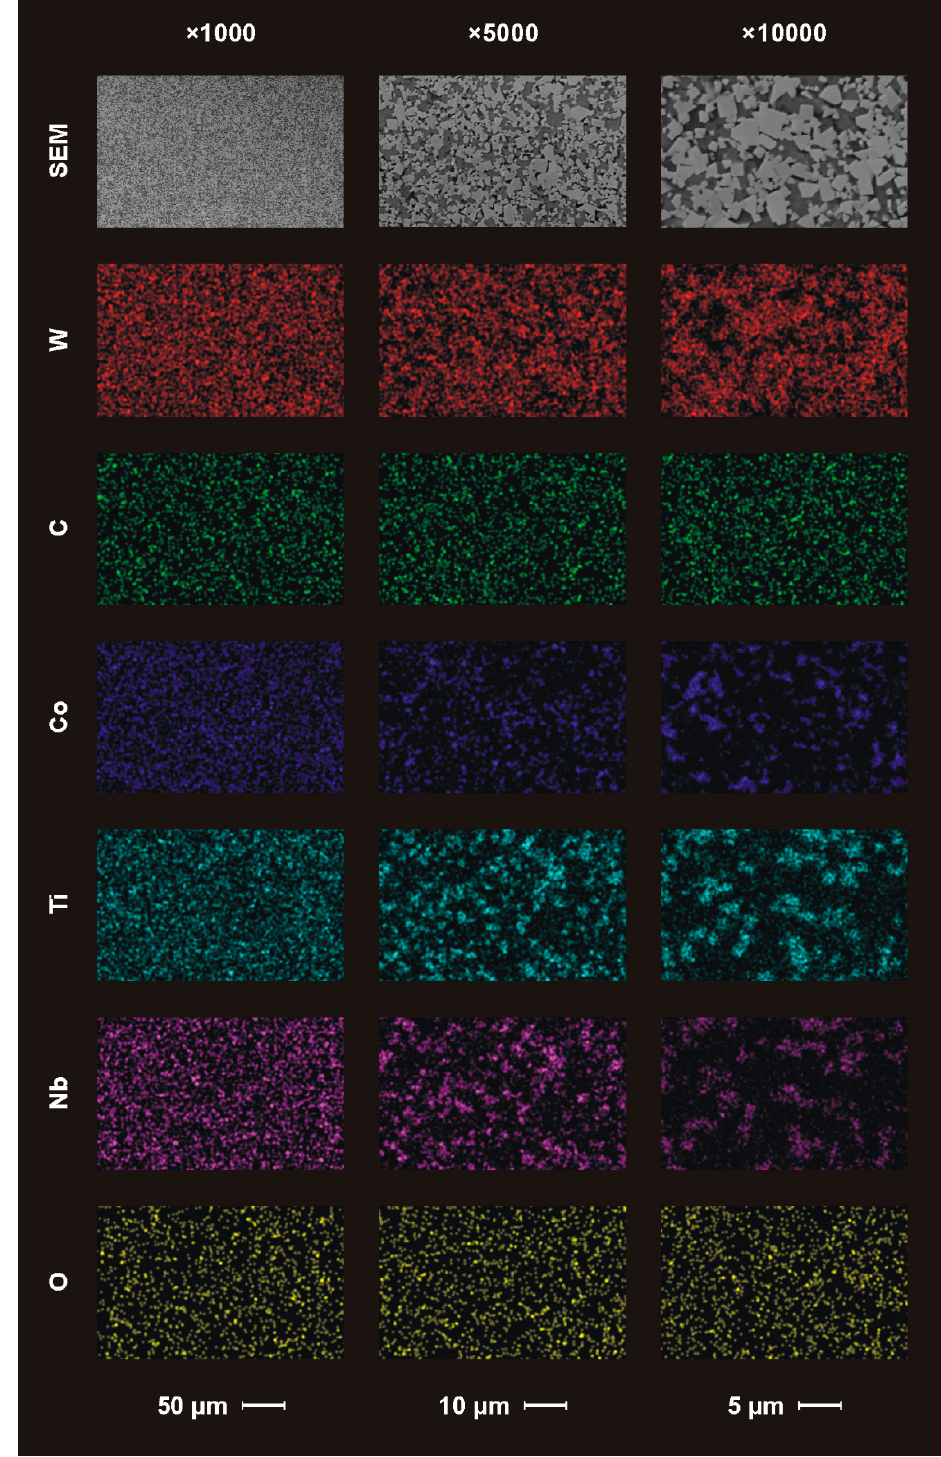
Figure 3. Scanning electron microscope (SEM) images and energy dispersive spectroscopy (EDS) maps of chemical composition of the nonimplanted guide pads’ surfaces.